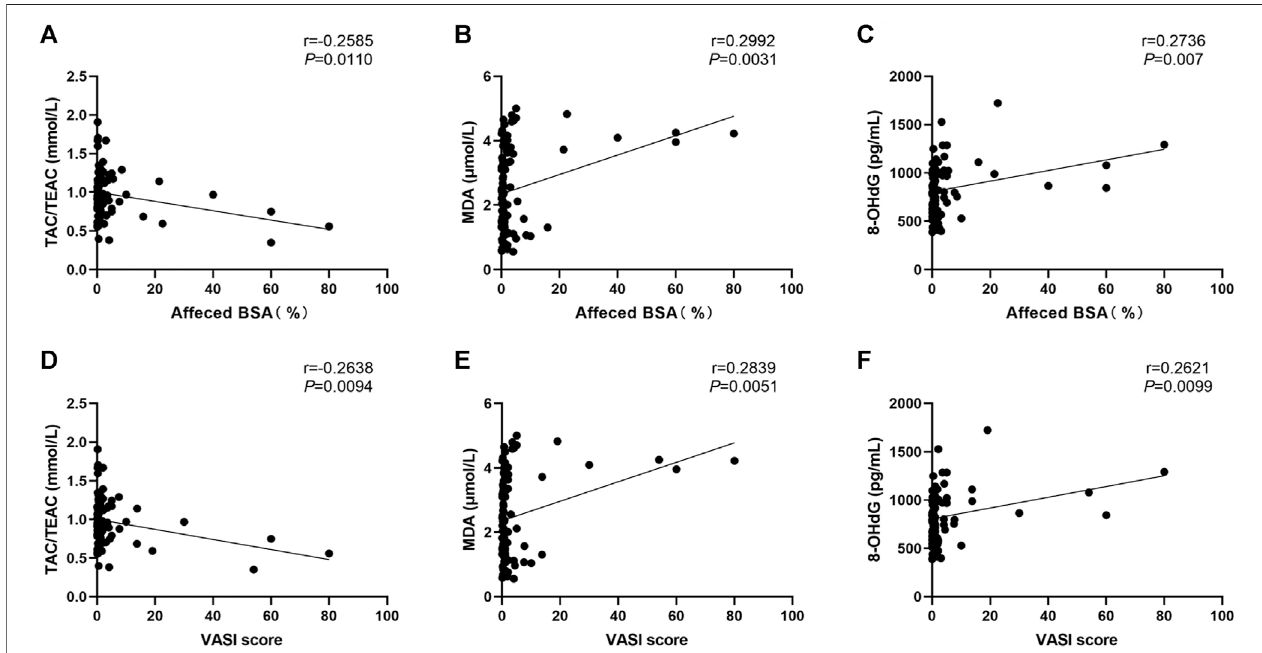
FIGURE 4 | Correlation between serum TAC, MDA, and 8-OHdG levels with the affected BSA (A, B, C) and VASI score (D, E, F) in patients with NSV. TAC, total antioxidant capacity; TEAC, Trolox equivalent antioxidant capacity; MDA, malondialdehyde; 8-OHdG, 8-hydroxy-2-deoxyguanosine; BSA, body surface area; VASI, Vitiligo Area Scoring